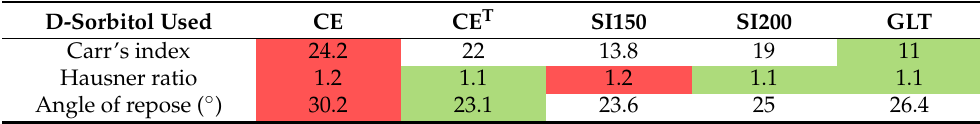
Table 5. Summary of D-Sorbitol CE, CE T , SI150, SI200 and GLT flowability measurement (green for the best flowability results and red for the worst flowability